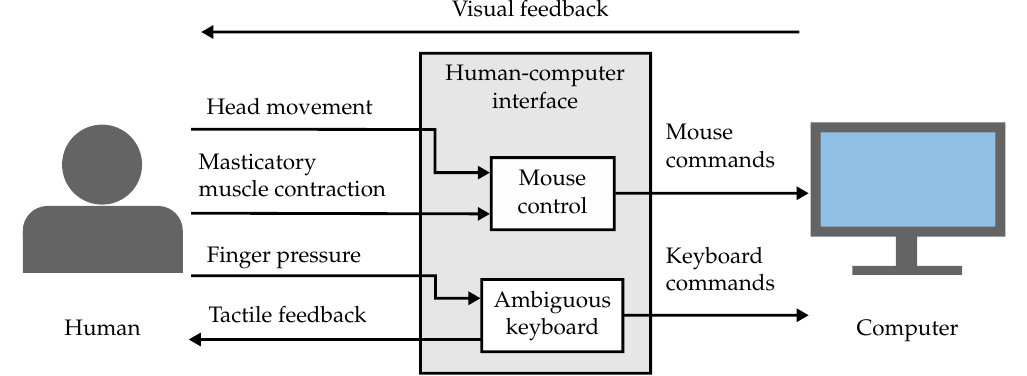
Figure 1. Overall concept of the human–computer interface. Head movements and masticatory muscle contractions are combined to generate mouse commands. Finger pressure functions as input of an ambiguous keyboard which is presented on the screen. Tactile feedback is given when a keystroke is recognized by the ambiguous keyboard.